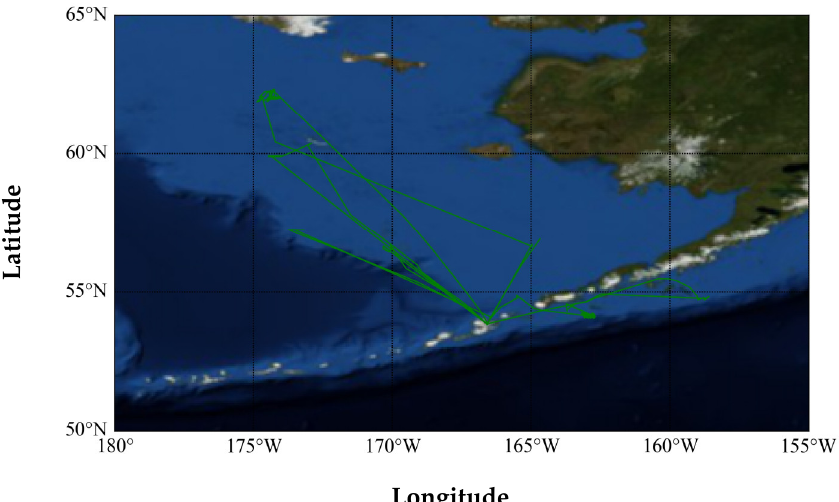
Figure 6. The historical trajectory of the ship (MMSI: 367588710).